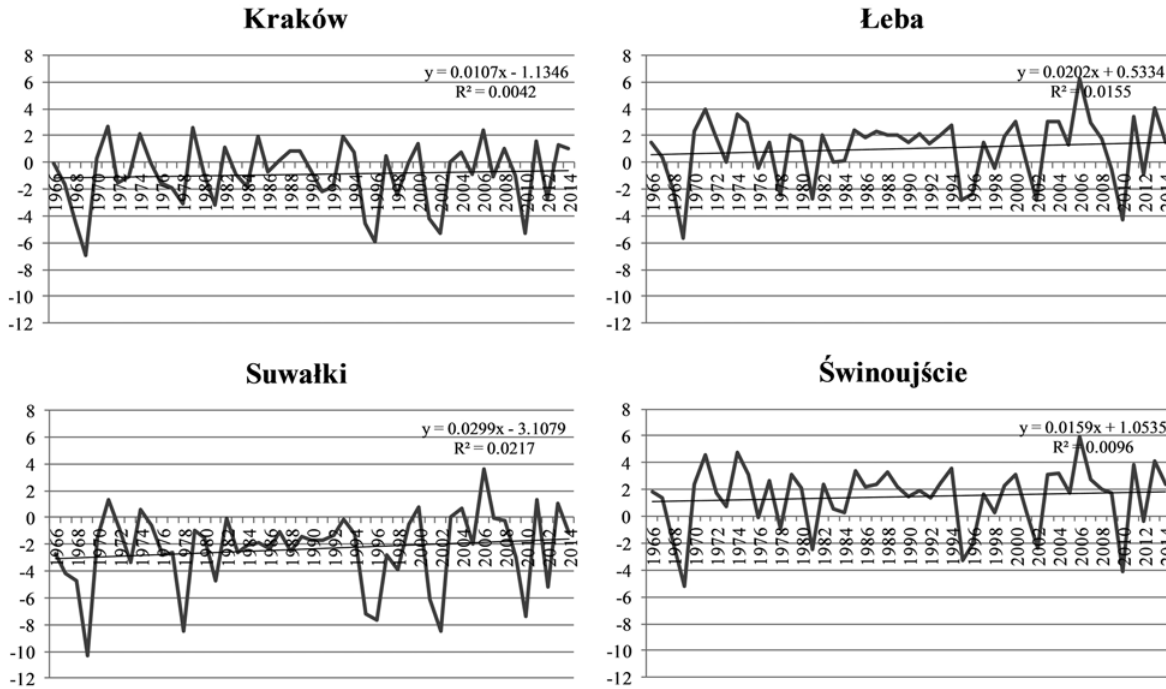
Fig. 2. Mean air temperature (°c) in december between 1966 and 2014 in selected